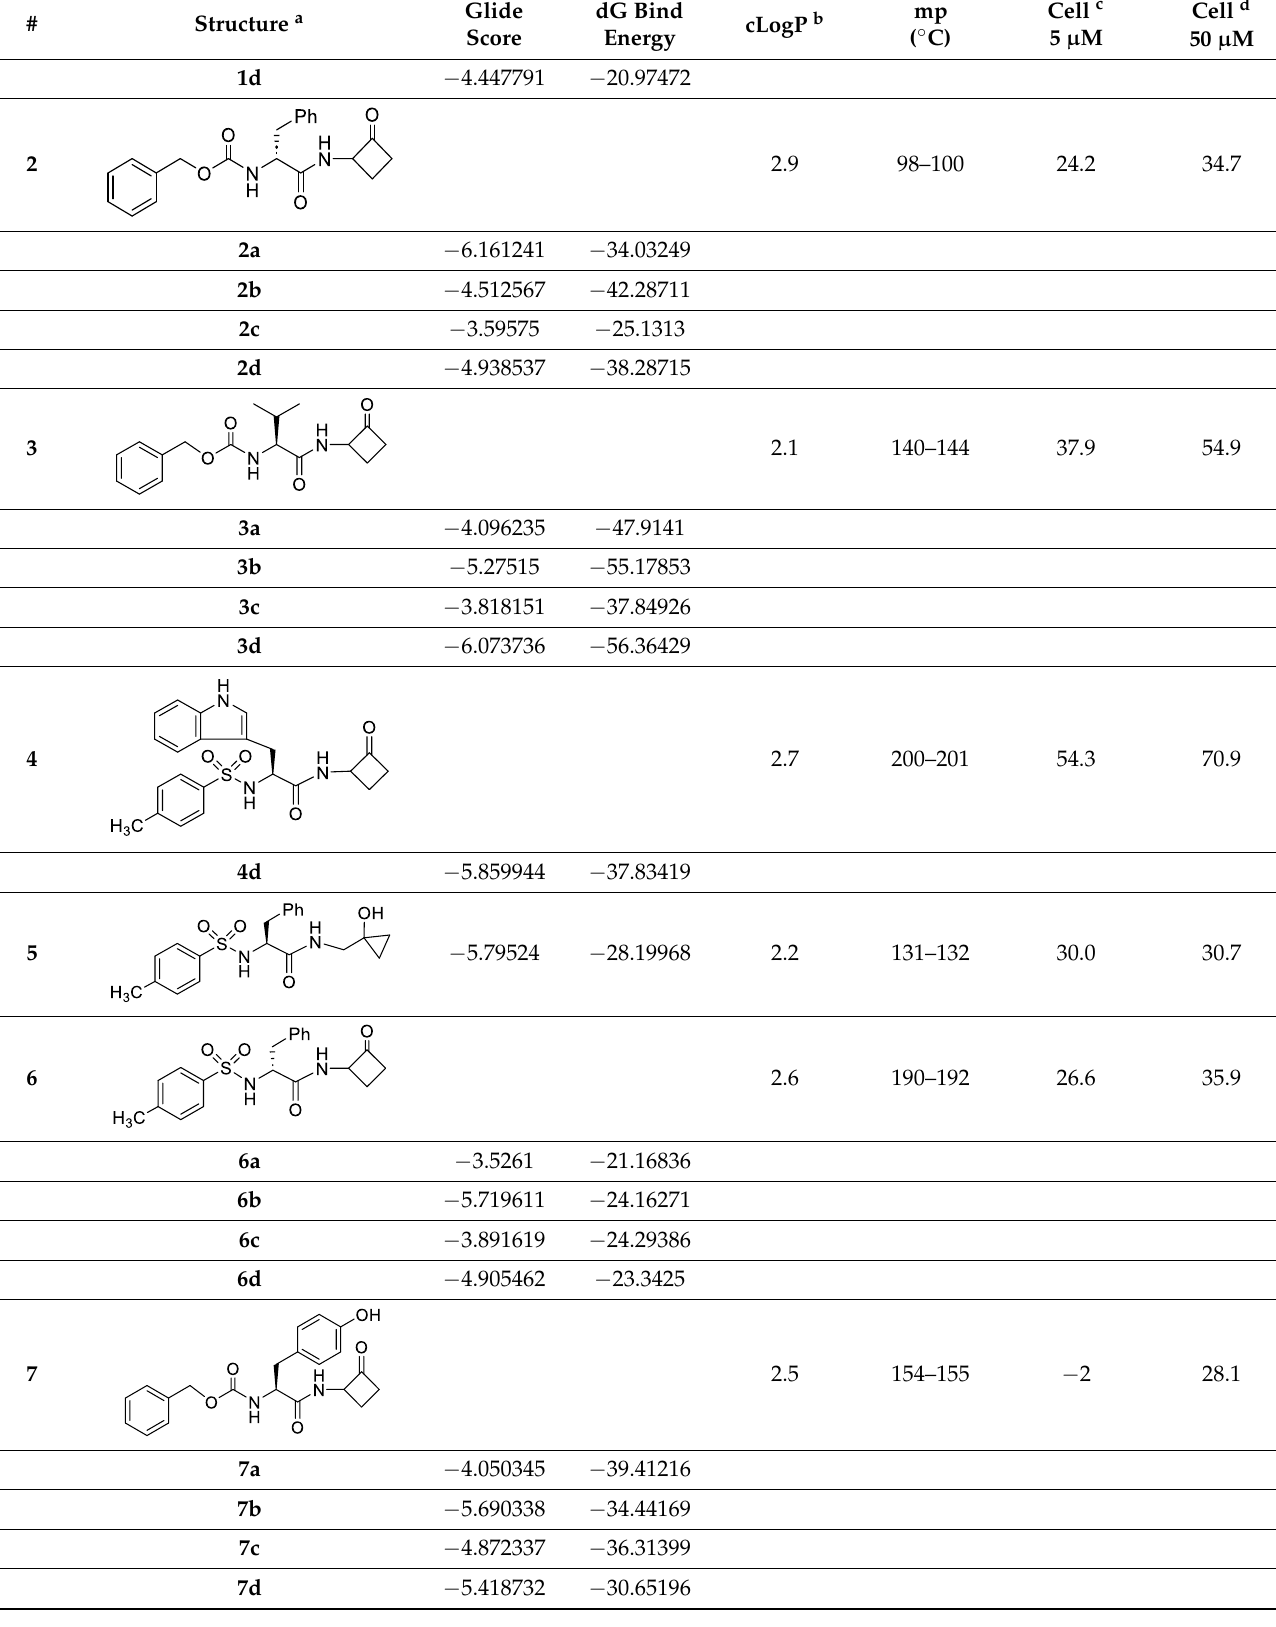
Table 1. Docking parameters and calculated energies of amino acid-derived cyclobutanone hits against SARS-CoV-2 Nsp13 helicase, physicochemical properties, and antiviral cell-based assay re- sults.